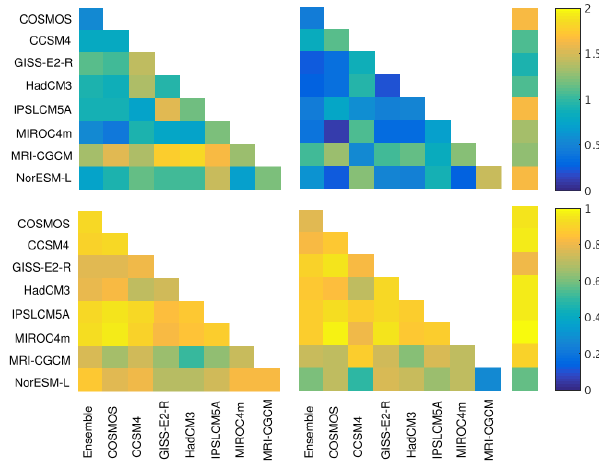
Figure 4. Root-mean-square deviation (RMSD, m) (top) and spatial pattern correlations (SPC) (bottom) of mean annual Arctic sea ice thickness (for ice-covered areas north of 60 ◦ N) in the pre-industrial (left) and mid-Pliocene (right) simulations by the PlioMIP mod- els and ensemble mean. The single columns to the right show the RMSDs and SPCs between each model’s pre-industrial and mid- Pliocene mean annual Arctic sea ice